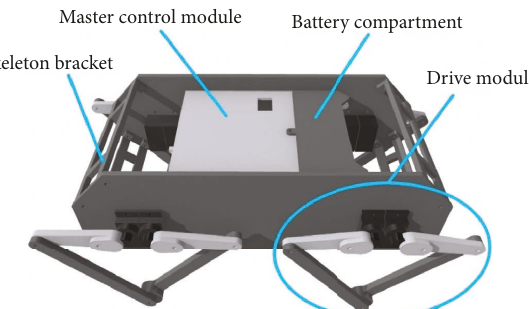
Figure 4: Top view of the quadruped robot.